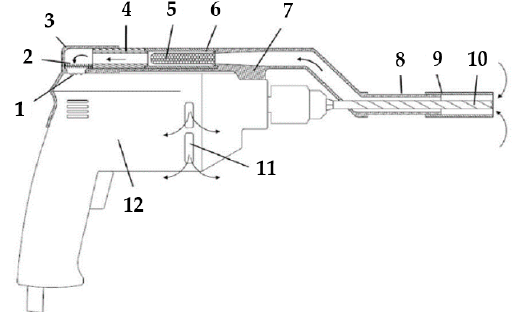
Figure 1. Cross-section view of the Wood Extractor device. Main components: 1 air intake, 2 spring, 3 enveloping structure, 4 telescopic tube, 5 paper filter bag, 6 cartridge, 7 clamp, 8 coaxial pipes, 9 telescopic system, 10 drill bit, 11 side holes, 12 power drill. The arrows indicate airflow.